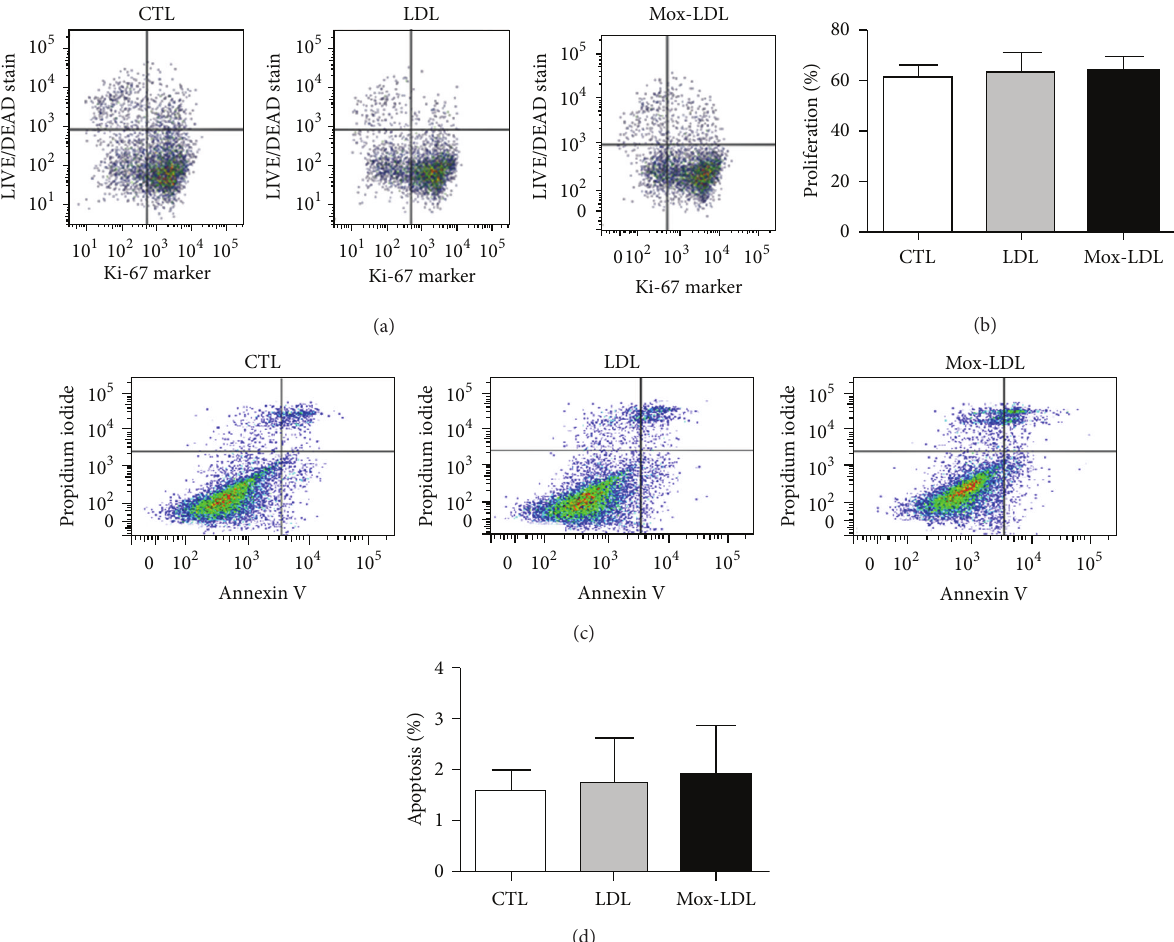
Figure 5: Effect of Mox-LDL treatment on HUVEC proliferation. (a) A representative Flow cytometry analysis of HUVEC cells incubated for 24 hours in culture medium supplemented with mock medium, native LDL, or Mox-LDL. Cells were then harvested and analyzed for the dead cell stain and the Ki67 proliferation marker. Percentages of cells located in the different quadrants are indicated. (b) Statistical analysis of the percentages of proliferating cells determined as in (a) on 3 independent experiments performed in duplicate. Mean ± SEM (ANOVA, Turkey’s multiple comparison test). Effect of Mox-LDL treatment on HUVEC cell death. (c) A representative flow cytometry analysis of HUVEC cells incubated for 24 hours in culture medium supplemented with mock medium, native LDL, or Mox-LDL. Cells were then harvested and analyzed for PI DNA staining and phosphatidylserine annexin V staining. Percentages of cell located in the different quadrants are indicated. The results are representative of three independent experiments performed in duplicate. (d) Statistical analysis of the percentages of PI-negative annexinV positive cells determined as in (c) on 3 independent experiments performed in duplicate. Mean ± SEM (ANOVA, Turkey’s multiple comparison